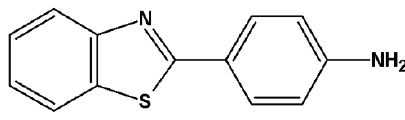
Figure 1. Chemical structure of CJM